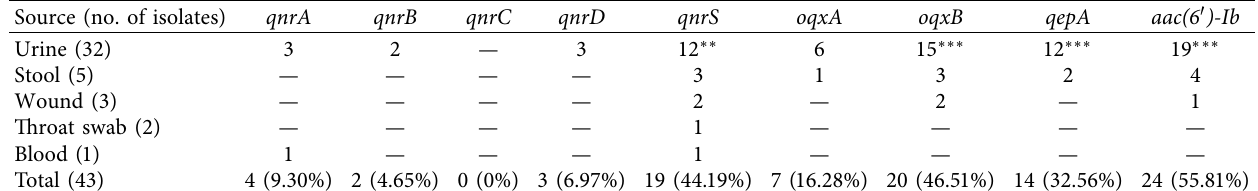
Table 2: The PMQR genes distribution among different